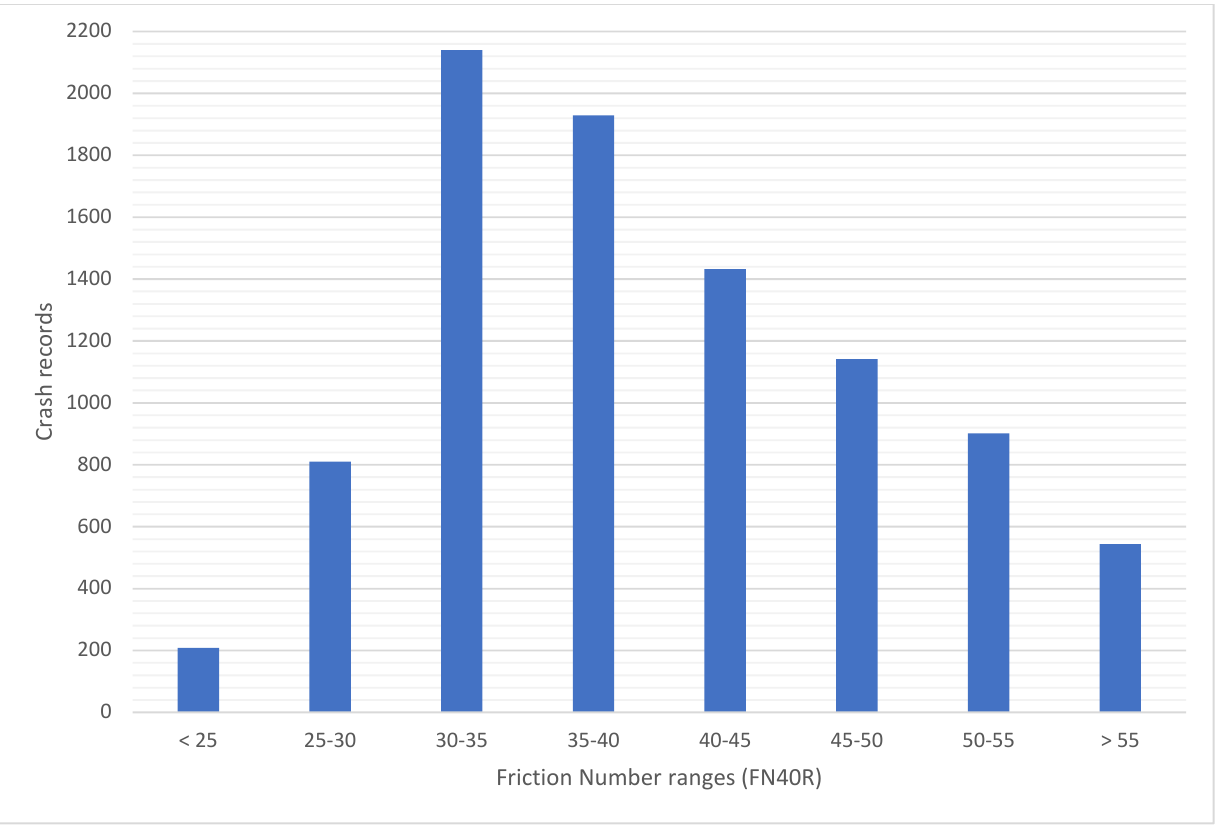
Figure 1. Friction number distribution by crash frequency.